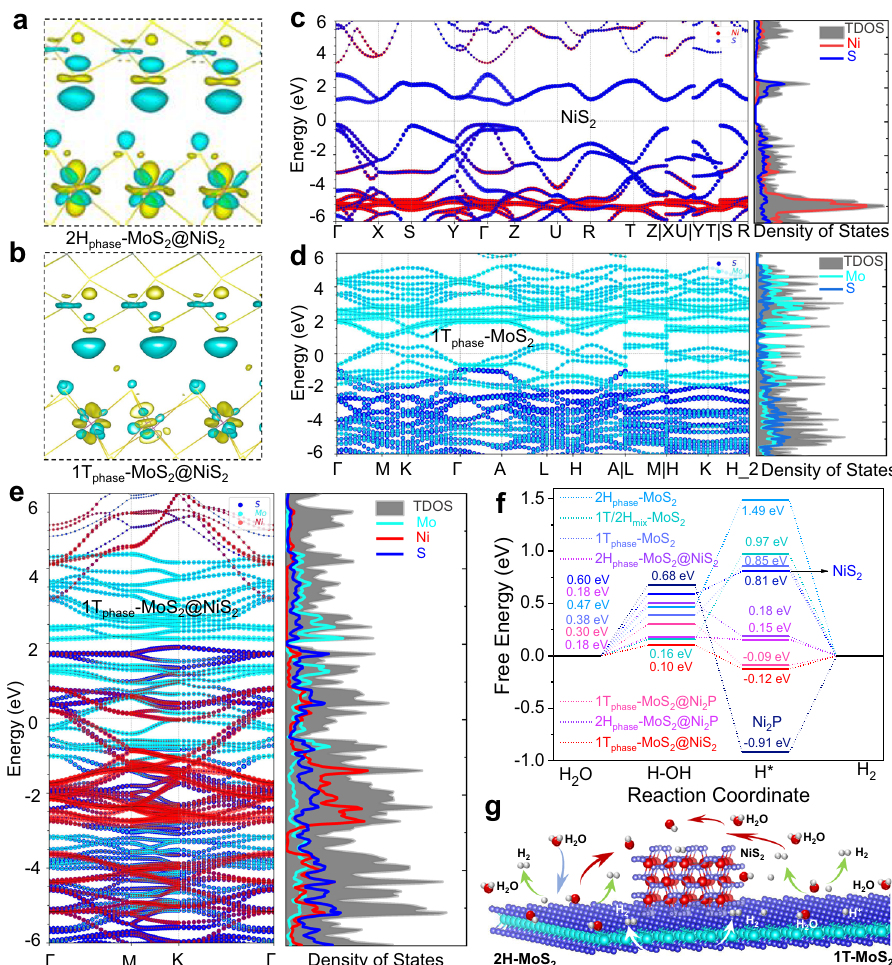
Fig. 4 Theoretical calculation and mechanisms analysis of the surface structure and HER activation energy of the as-prepared electrocatalysts. the deformation of the electronic density of a 2H phase -MoS 2 @NiS 2 and b 1T phase -MoS 2 @NiS 2 interface, in which yellow/green isosurfaces correspond to positive/negative spin densities (0.00295308 e/Å 3 ). Band structure and density of states (DOS) for c NiS 2 , d 1T phase -MoS 2 and e 1T phase -MoS 2 @NiS 2 . f Free-energy diagrams for HER on the 2H phase -MoS 2 , 1T phase -MoS 2 , pure Ni 2 P, pure NiS 2 , 1T/2H mix -MoS 2 , 2H phase -MoS 2 @Ni 2 P, 2H phase -MoS 2 @NiS 2 ,